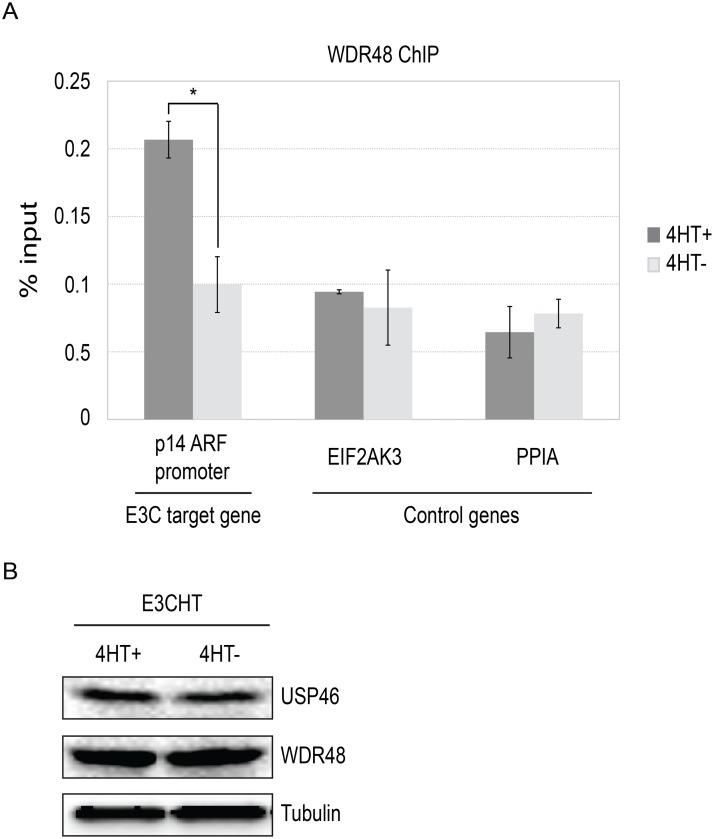
ChIP assay for WDR48 at the p14ARF promoter.Chromatin immunoprecipitation (ChIP) assays were performed using antibodies for WDR48 (A) from EBNA3C-HT LCLs that were grown in the presence of 4HT (dark gray) or after 14 days of growth in the absence of 4HT (light gray). Amount of genomic DNA was measured by real time PCR using primers specific to the EBNA3C binding site in the p14ARF promoters or sites near the EIF2AK3 and PPIA genes which bind cell transcription factors but not EBNA3C. The bar graph represents the amount of DNA precipitated relative to the amount of DNA in the corresponding input sample. The experiment shown is representative of four independent experiments and error bars indicating standard error of the mean within this experiment. Asterisk denotes that the difference in ChIP signal seen at the p14ARF promoter is statistically significant (p = 0.01). (B) Western blot for USP46, WDR48, and tubulin levels in whole cell lysates from EBNA3CHT LCLs grown in the presence of 4HT or after 14 days of growth in the absence of 4HT.